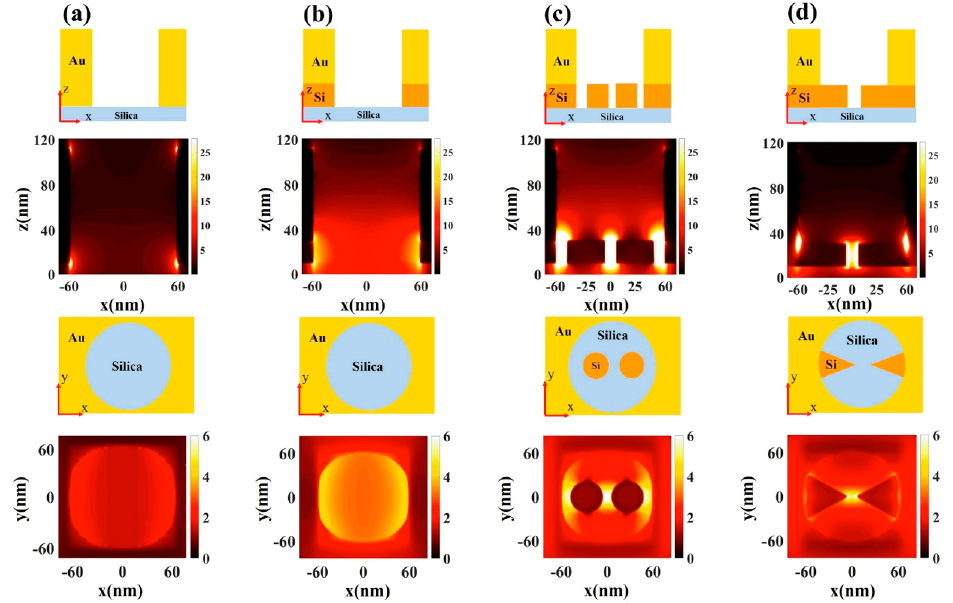
Figure 4. Electric field distribution |E/E 0 | 2 and corresponding schematics in the xz ‐ plane and the xy ‐ plane for ( a ) Au nano ‐ aperture at 573 nm; ( b ) Au/Si hybrid nano ‐ aperture at 785 nm; ( c ) Au/Si hybrid nano ‐ aperture with a silicon disk dimer at 758 nm; and ( d ) Au/Si hybrid nano ‐ aperture with a silicon triangle gap at 758 nm. The diameters of all of the apertures are 120 nm and the silicon thickness is 20 nm. The disks’ diameter in ( c ) is 40 nm, and the silicon gaps are 10 nm both in ( c , d ).